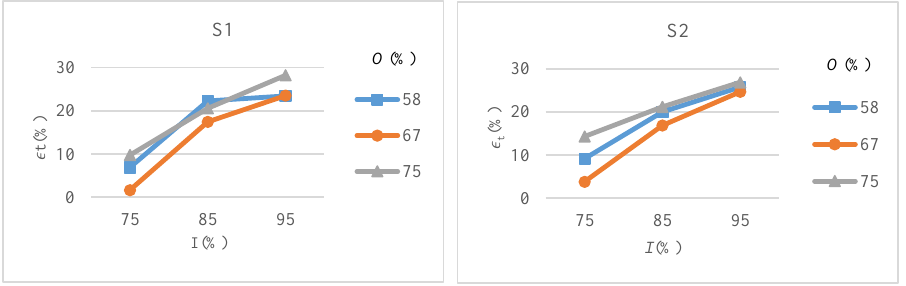
Figure 8. Top width error (𝜖 𝑡 ) as a function of intensity ( I ) and overlap ( O ) for scanning pattern S1 and S2.